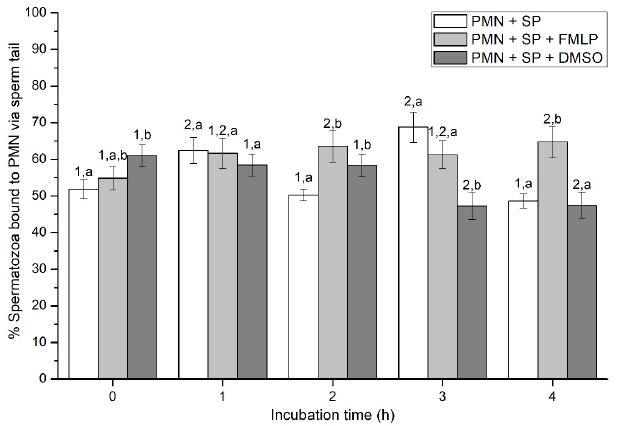
Figure 5. Percentages of viable spermatozoa bound to PMN via sperm tail in the three treatments (PMN + SP, PMN + SP + FMLP and PMN + SP + DMSO) throughout the incubation time (4 h; Experiment 2). Di ff erent superscripts (a, b) mean significant ( p < 0.05) di ff erences between treatments within a given time point, and di ff erent numbers (1, 2) mean significant ( p < 0.05) di ff erences between incubation times within a given treatment. Data are shown as mean ± SEM for seven experiments. Sperm concentration: 500 × 10 6 sperm / mL. PMN concentration: 100 × 10 6 PMN / mL. PMN: polymorphonuclear neutrophils; SP: seminal plasma; DMSO: dimethyl sulfoxide; FMLP: